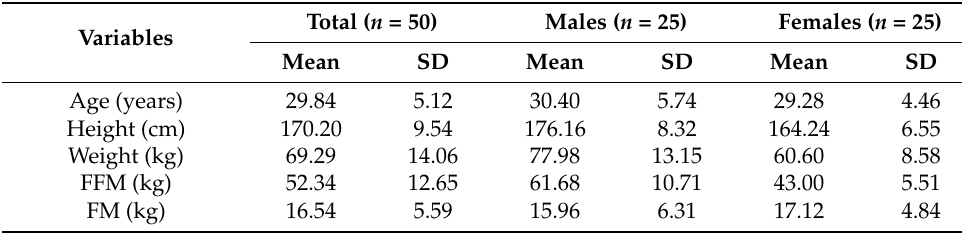
Table 1. Participants